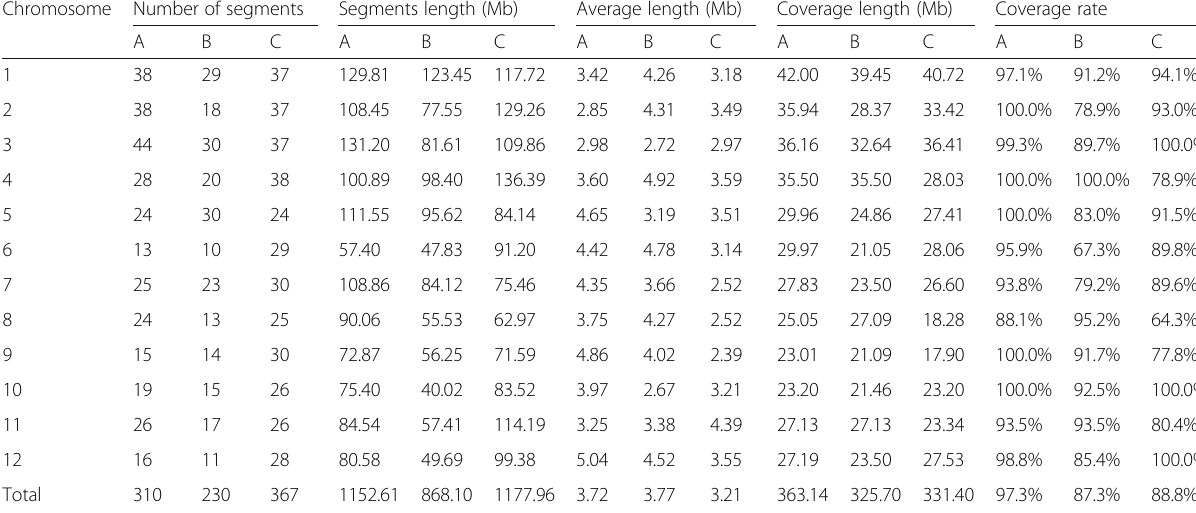
Table 1 Distribution of substituted segments on 12 chromosomes for 3 sets of CSSLs Chromosome Number of segments Segments length (Mb) Average length (Mb) Coverage length